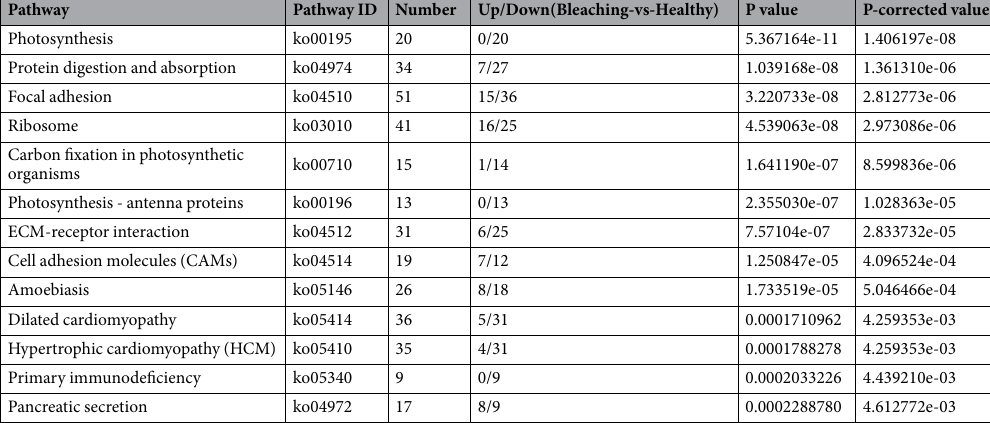
Table 1. Top thirteen enriched KEGG pathways involving differentially expressed mRNAs in P . caribaeorum .